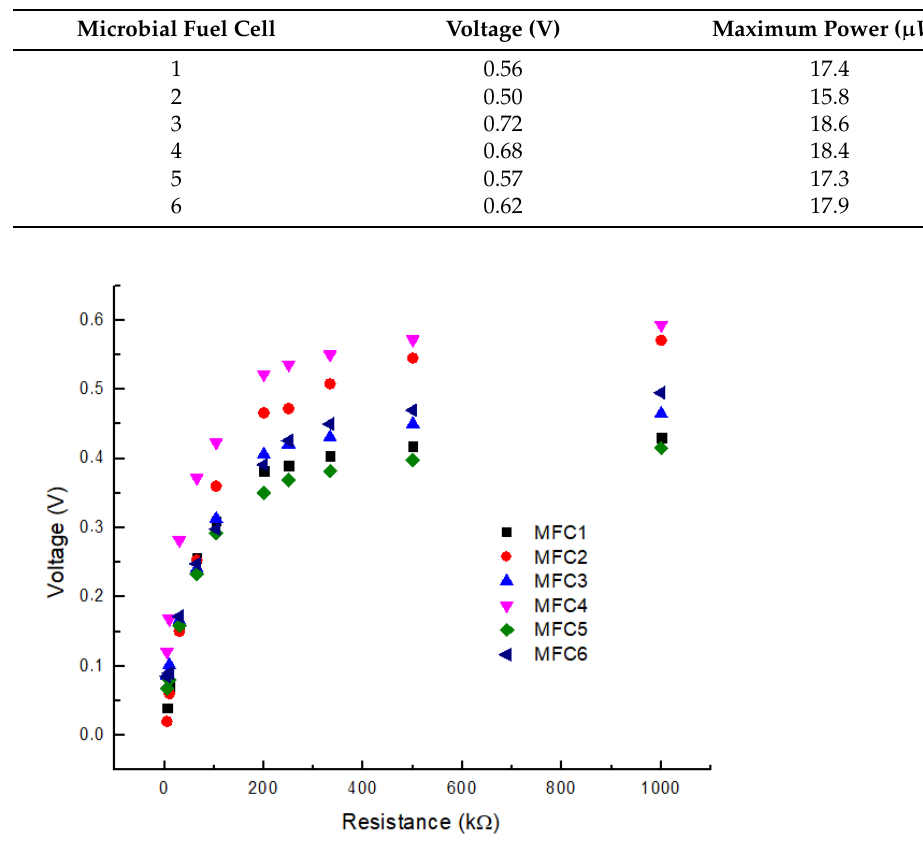
Figure 7. Voltage curve of each MFC while powering the system.